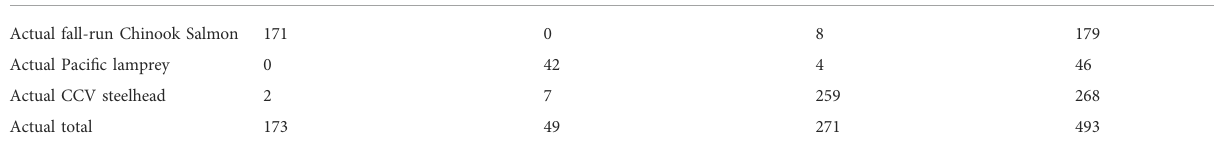
TABLE 3 Predicted (column) and actual (row) species designations in discriminant function analysis. “ Total ” column indicates predicted number of redds, and “ Total ” row indicates actual number of redds for each species.